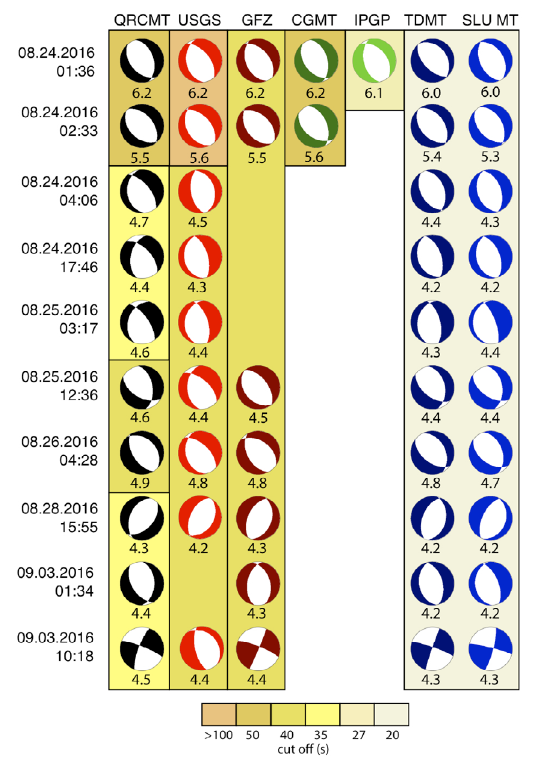
Figure 2. In the first colum, Quick RCMTs computed for 10 events of the Amatrice seismic sequence. On the left, date and time of the earthquakes. Other columns are the other rapid focal mechanisms available; for references see the text. The color in the background represents the dif- ferent cut off values used in each computation